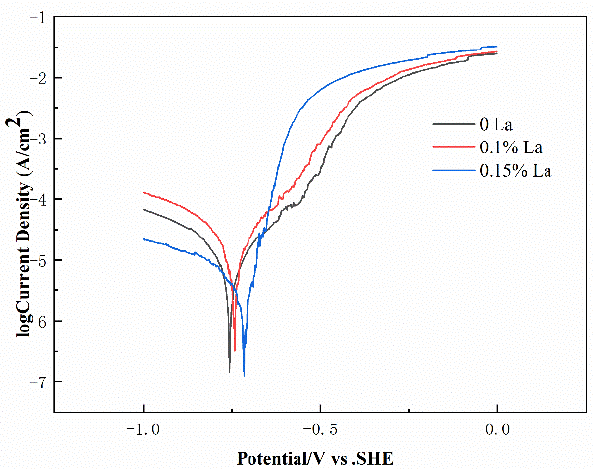
Figure 8. Tafel polarization curves of the alloys with different La content. Table 3. Electrochemical parameter of the alloys with different La content. Alloys